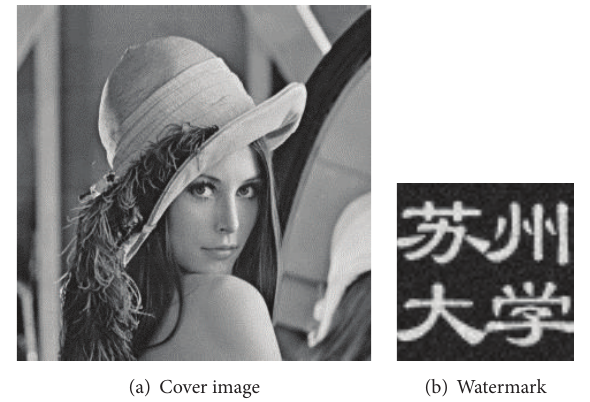
Figure 2: Cover and watermark